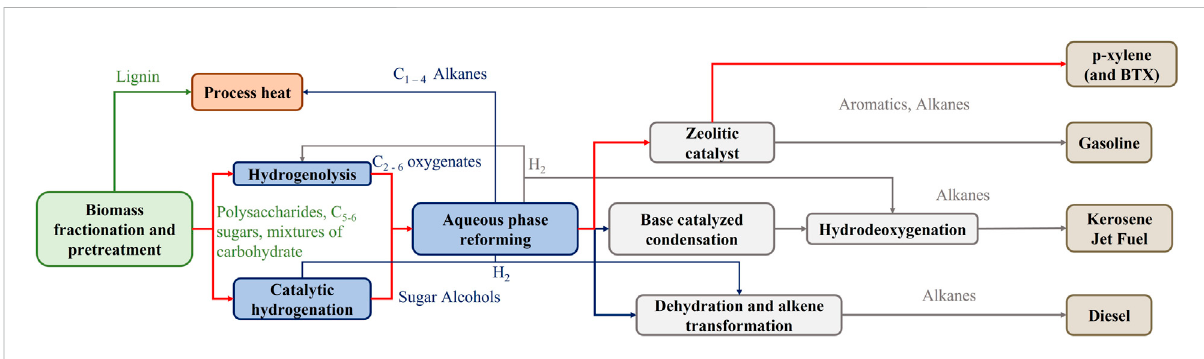
FIGURE 8 Schematic illustration of the BioForming ® process, with the route to p-xylene in red (adapted from Green Car Congress,